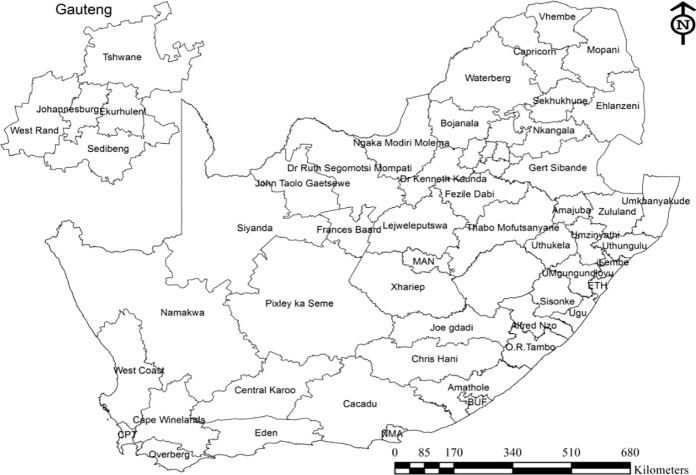
Map of health districts in South Africa.